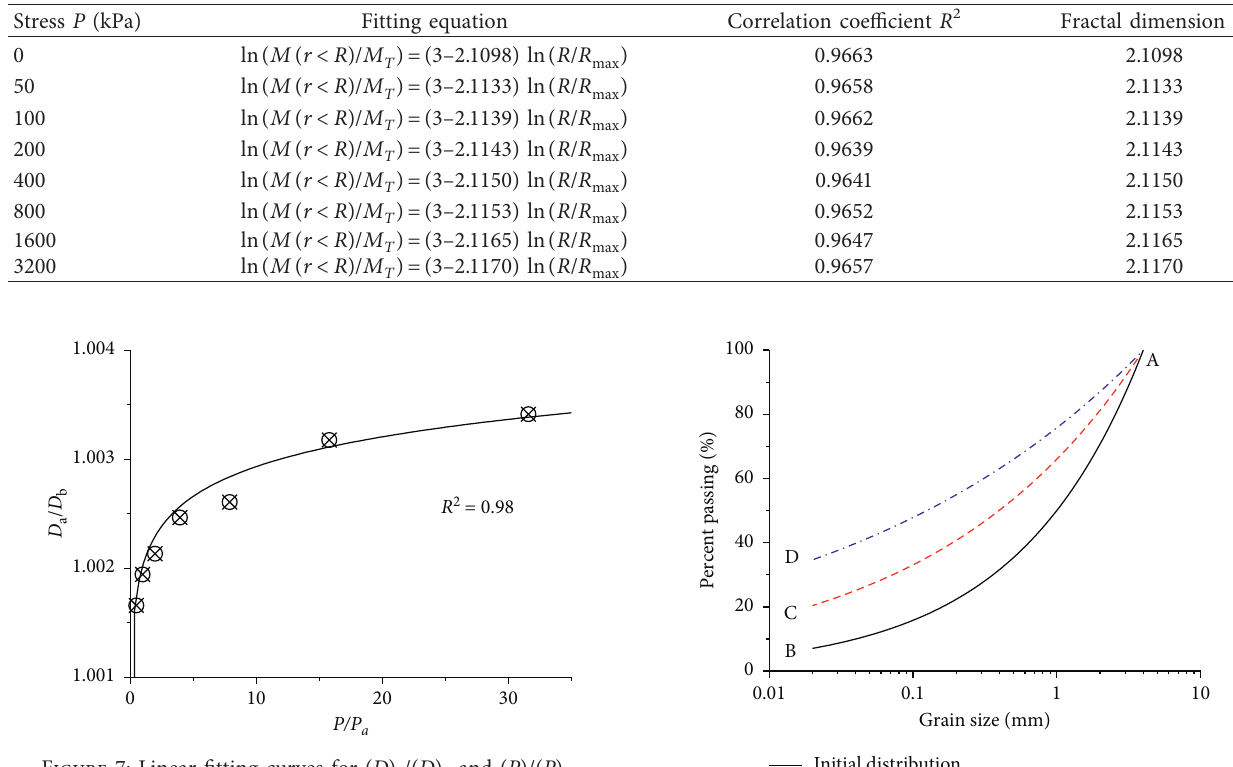
a /( D ) b and ( P )/( P ) a .